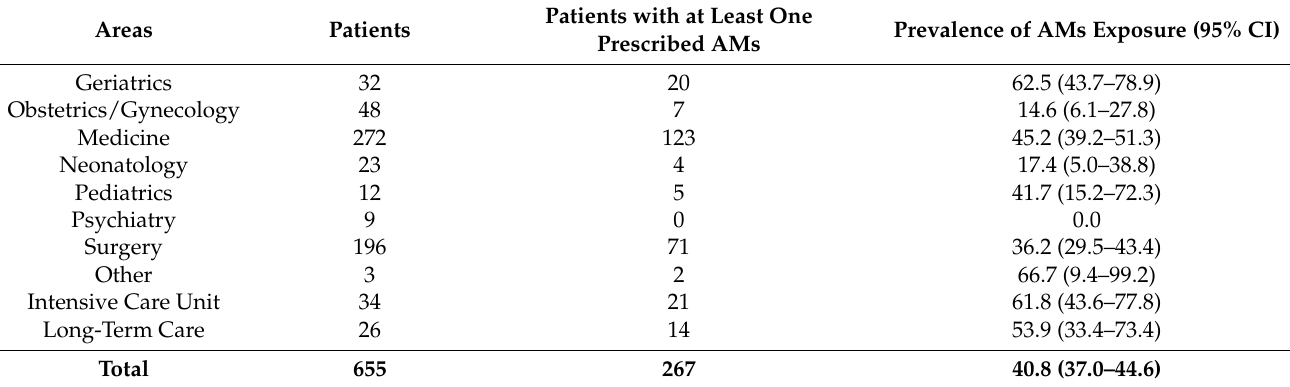
Table 4. Prevalence of antimicrobials use by ward specialty.